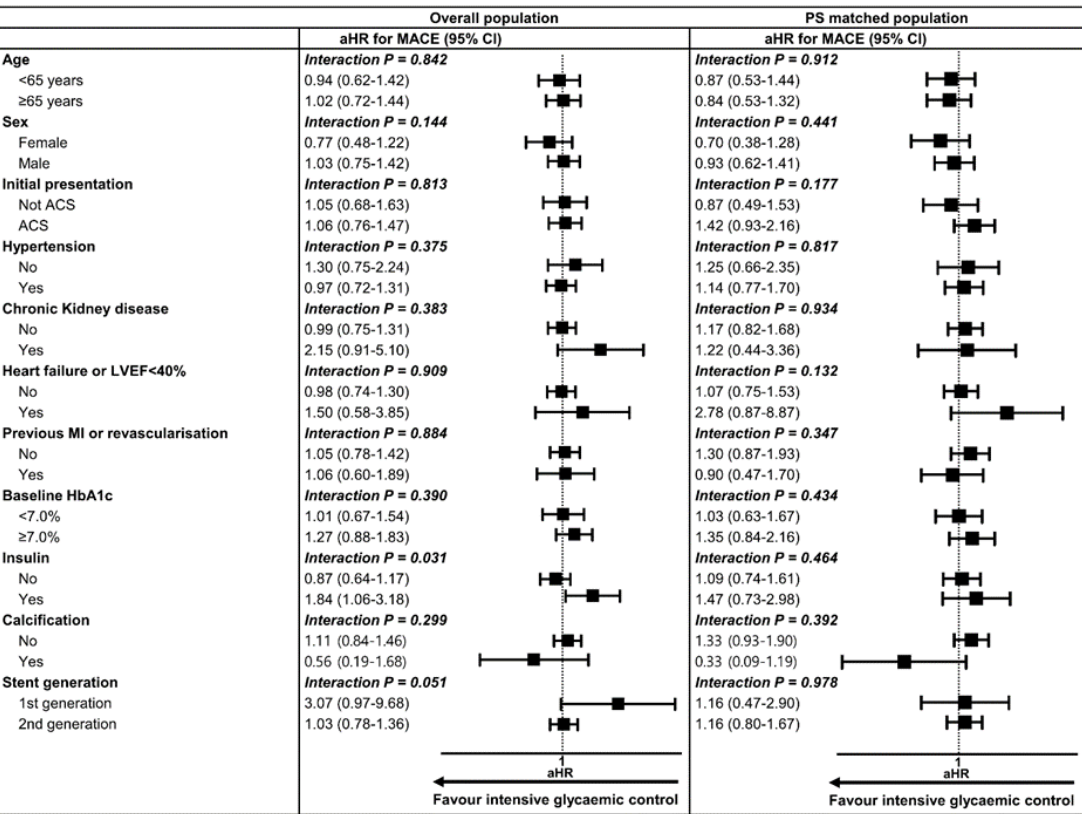
Figure 4. Subgroup analysis of clinical outcomes according to mean HbA1c cut-off of 7.0%. In subgroup analysis, mean HbA1c < 7.0% group showed no significant risk reduction for MACE compared with mean HbA1c ≥ 7.0% group across various subgroups except for those with insulin treatment. For subgroup with insulin treatment, HbA1c < 7.0% group was associated with a higher risk of MACE than HbA1c ≥ 7% group. ACS = acute coronary syndrome, CI = confidence interval, aHR = adjusted hazard ratio, LVEF = left ventricular ejection fraction, MACE = major adverse cardiovascular event, MI = myocardial infarction, PS = propensity score.